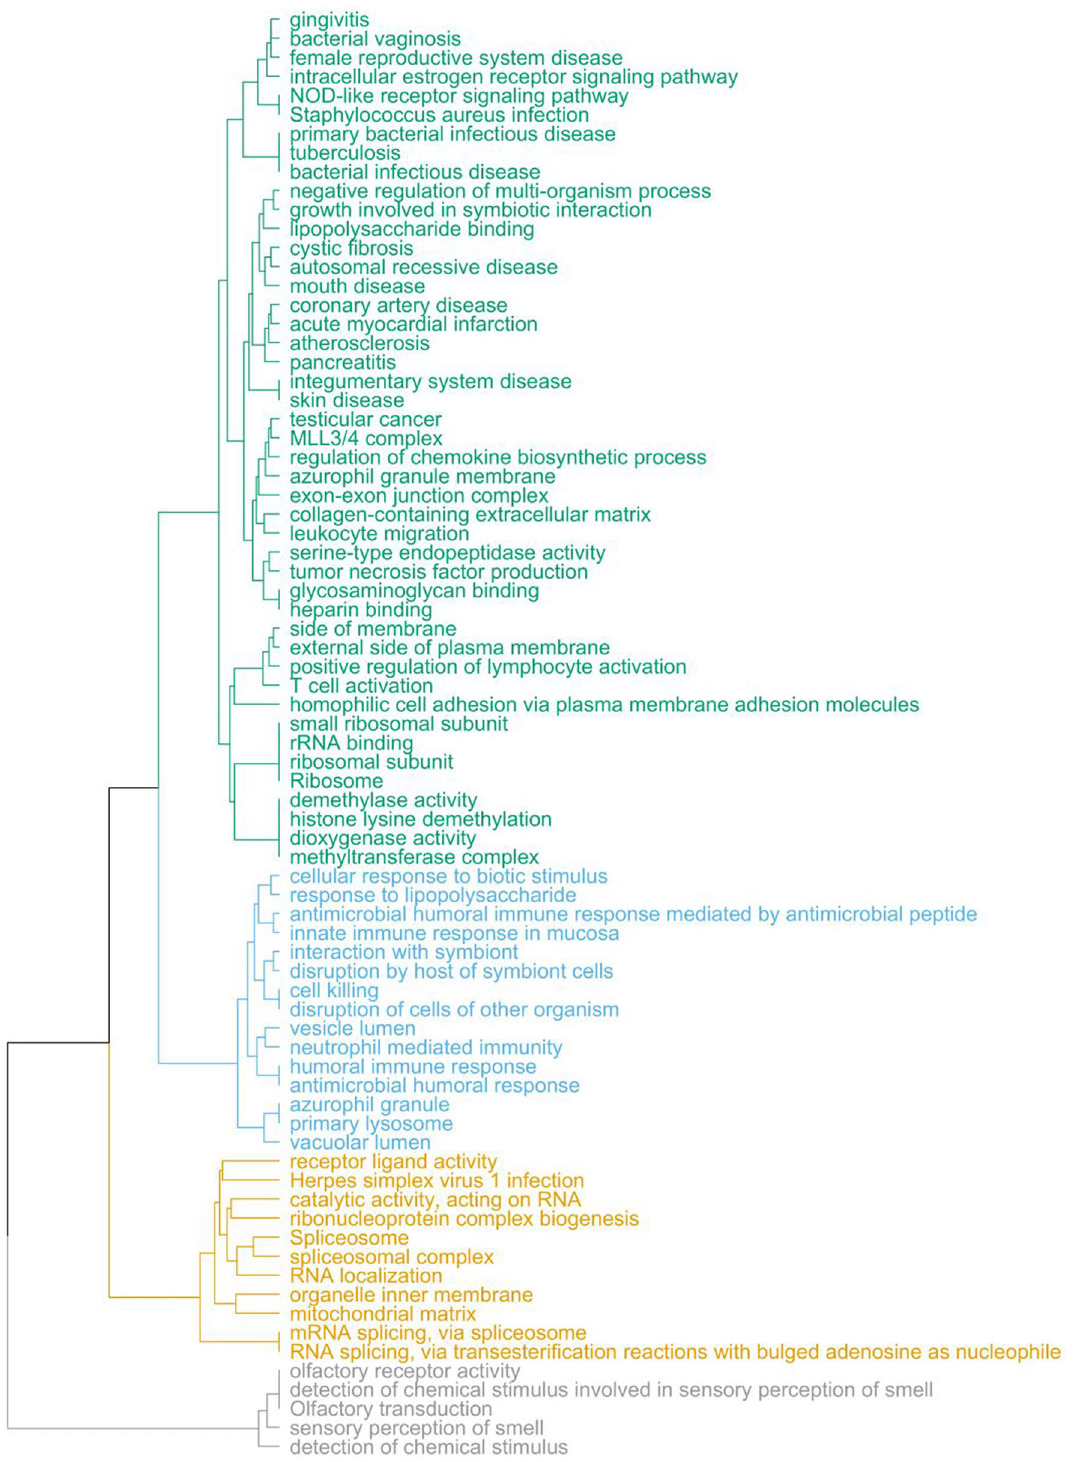
Figure 3. Biological pathways shared by early traits of osteoporosis and atherosclerosis. Dendrogram plot representing the hierarchical clustering of biological pathways significantly enriched (Bonferroni-adjusted p-value < 0.05) in member genes of the six significant joint gene modules ( brown4, honeydew1, darkseagreen4, lightcoral, green and tan ). The four clusters, from the largest to smallest in size, are represented by green, blue, orange and grey colours. Biological pathways were defined as sets of genes derived from three different knowledge bases: the Gene Ontology (GO), the Kyoto Encyclopedia of Genes and Genomes (KEGG) and the Disease Ontology